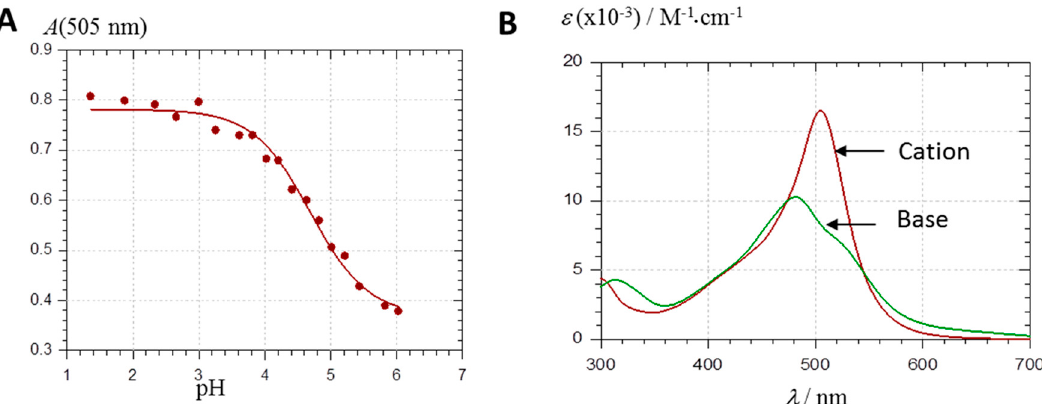
Figure 2. ( A ) Plot of the visible absorbance of PA1 (48.4 µM, citrate-phosphate buffer) at 505 nm (collected immediately after addition of PA1 to buffer) as a function of pH. The solid line is the result of the curve-fitting assuming a single proton transfer: p K a = 4.69 (±0.06), rA = ε A/ ε AH + = 0.47 (±0.02), r = 0.993; ( B ) normalized spectra of pure cation (pH 1.88) and pure base (spectrum at pH 4.64 after subtraction of ca. 50% of the residual cation).